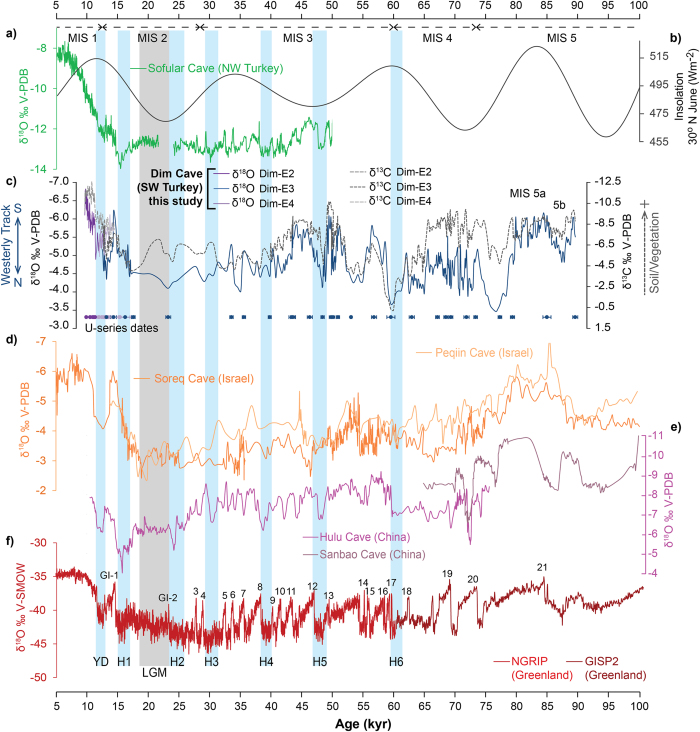
Comparison of the speleothem-based paleoclimatic records over the last 100 kyr.(a) δ18O time series of stalagmites from Sofular Cave, NW Turkey5 (inverted as per that publication); (b) summer insolation (30°N June46); (c) δ18O and δ13C composite time series of stalagmites Dim-E2, Dim-E3, and Dim-E4 from the Dim Cave (SW Turkey), colour-coded points denote for the U-series dates for Dim-E2 (purple), Dim-E3 (blue) and Dim-E4 (light purple). (d) Soreq and Peqiin Cave (Israel) δ18O records4; (e) composite stalagmite δ18O records from the Hulu and Sanbao Caves (China)4748; (f) δ18O ice-core time series from Greenland NGRIP49 and GISP250, numbers indicating Greenland Interstadials (e.g. GI-1). Marine Isotope Stages (e.g. MIS 1) are indicated by dashed horizontal arrows. Durations of Younger Dryas (YD), Heinrich (H) events, and LGM are highlighted by light blue and grey areas, respectively. Greenland data are provided to constrain Heinrich and other climate events.